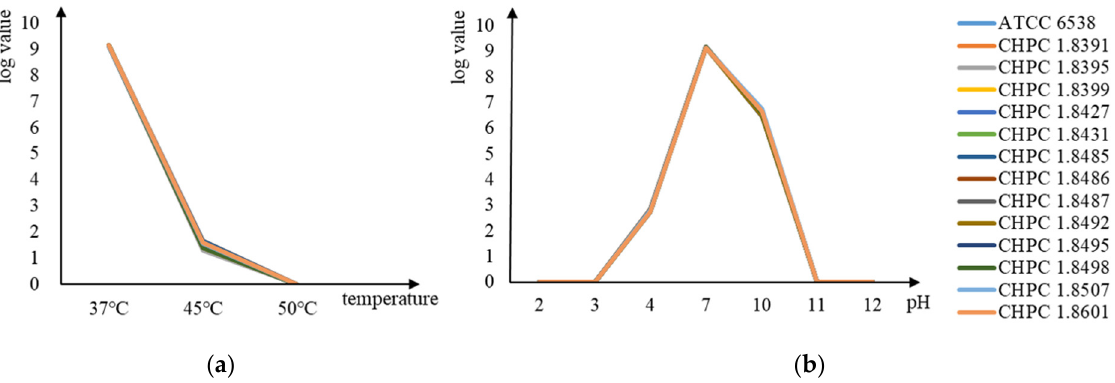
Figure 1. Growth condition of 14 strains in different environments. ( a ) The logarithm of viable bac- teria of 14 strains under different pH conditions. ( b ) The logarithmic number of viable bacteria of 14 strains under different temperature conditions.